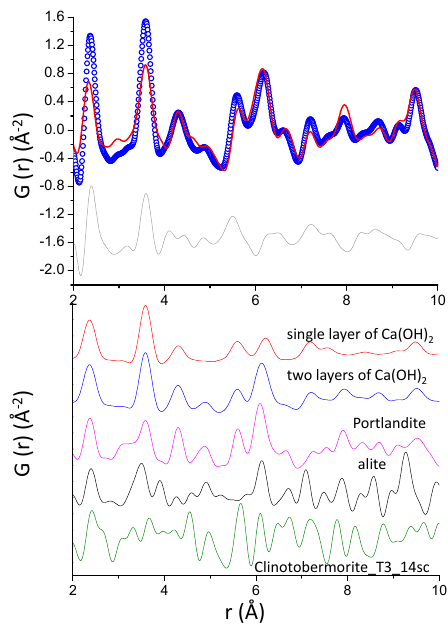
Figure 5. Experimental (blue circles) and fitted (red solid line) PDF patterns for Ca 3 SiO 5 w/s = 0.80 paste in the 2–10 Å r-range. The difference curve is shown as a grey line. Simulated PDF curves for a single layer and a double layer of calcium hydroxide, portlandite, alite, and clinotobermorite T3_14sc are also included.